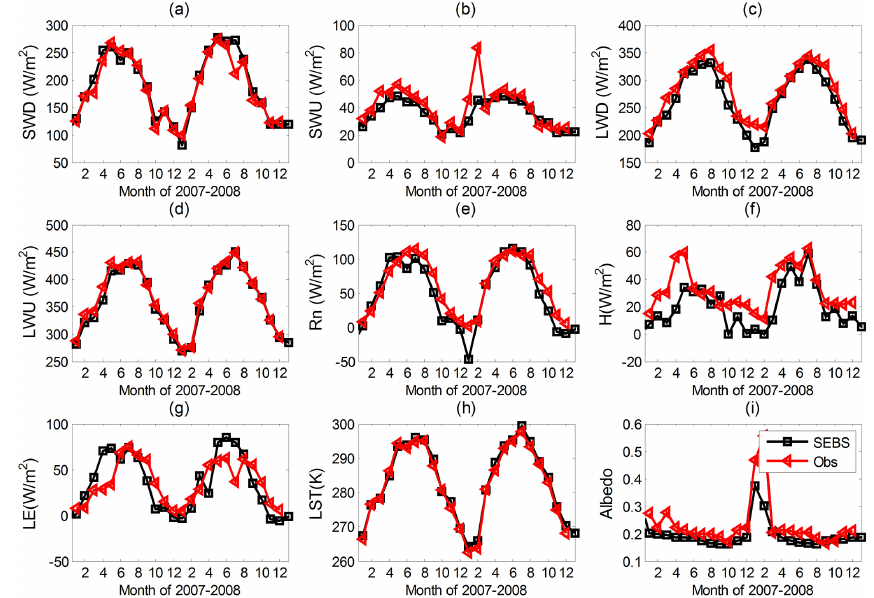
Figure 6. Time-series comparison of SEBS input and output variables against measurements at SC station. Black lines are SEBS results; red lines are measured values.